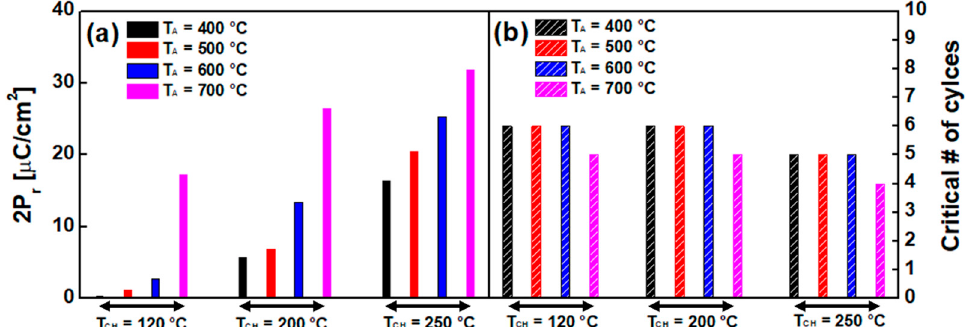
Figure 9. ( a ) Maximum remnant polarization (2P r ) and ( b ) critical number of cycles at which fatigue begins for given three different chamber temperatures, 120 °C, 200 °C, and 250 °C, with four different annealing temperatures (T A from 400 °C to 700 °C).